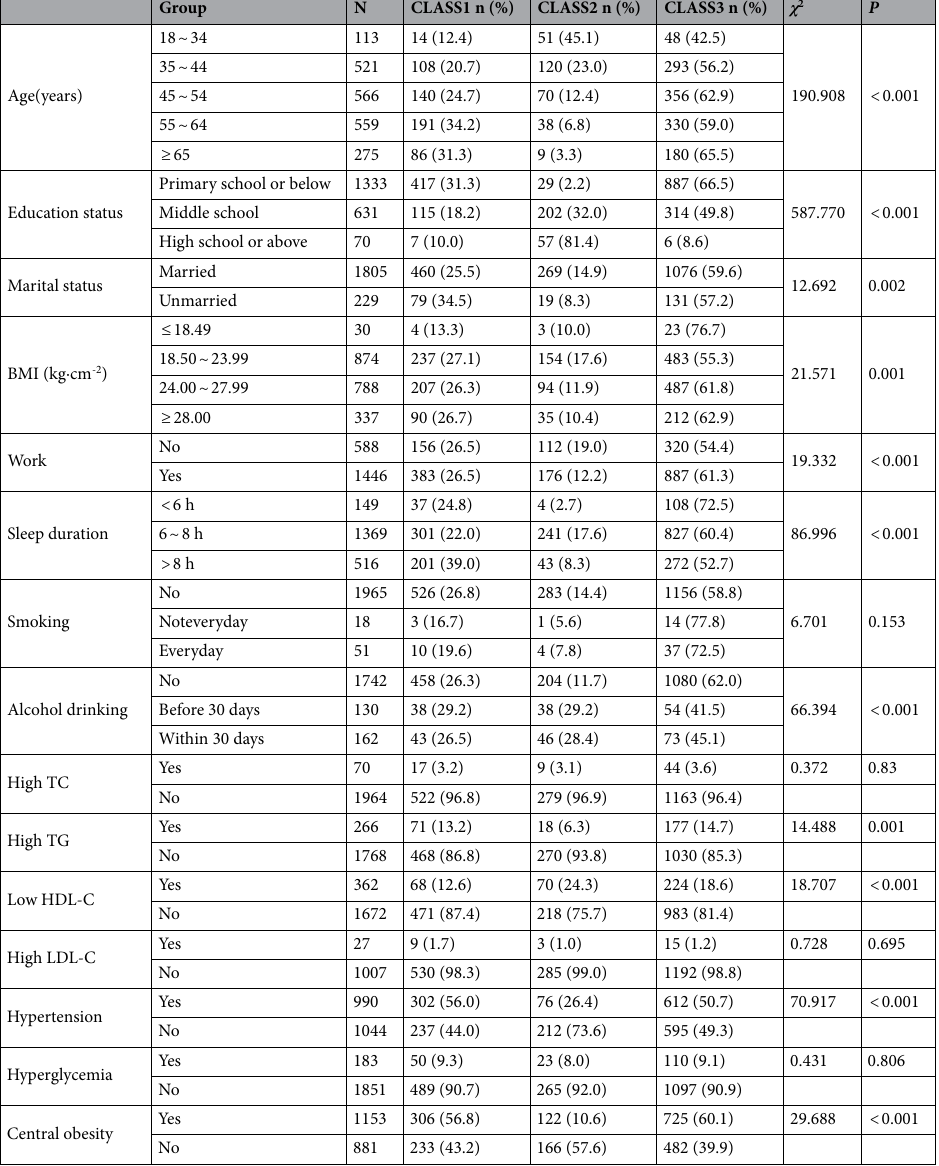
Table 4. Comparison of the distribution of characteristics among different potential categories of PA for females.